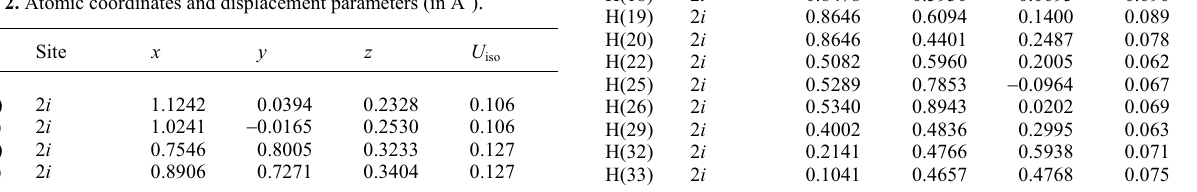
Table 2. Atomic coordinates and displacement parameters (in Å 2 ) .